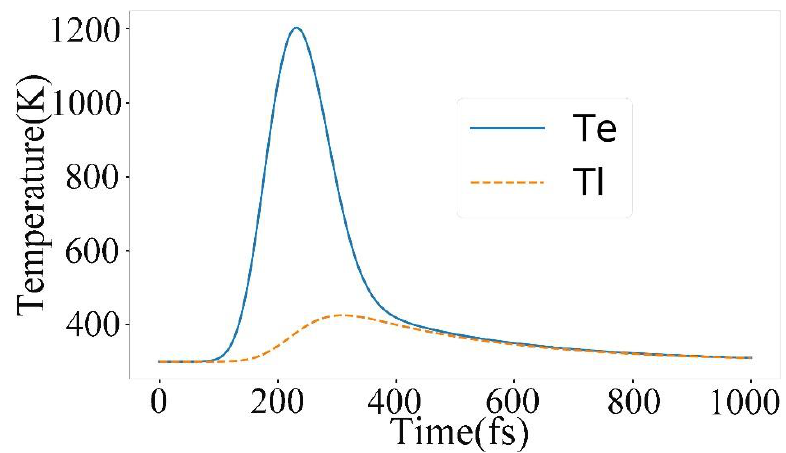
Figure 2. Two-temperature model for electrons and lattice. It can be seen that the temperature of electrons dramatically rises to T c of 500 K from room temperature of 300K within 150 fs.